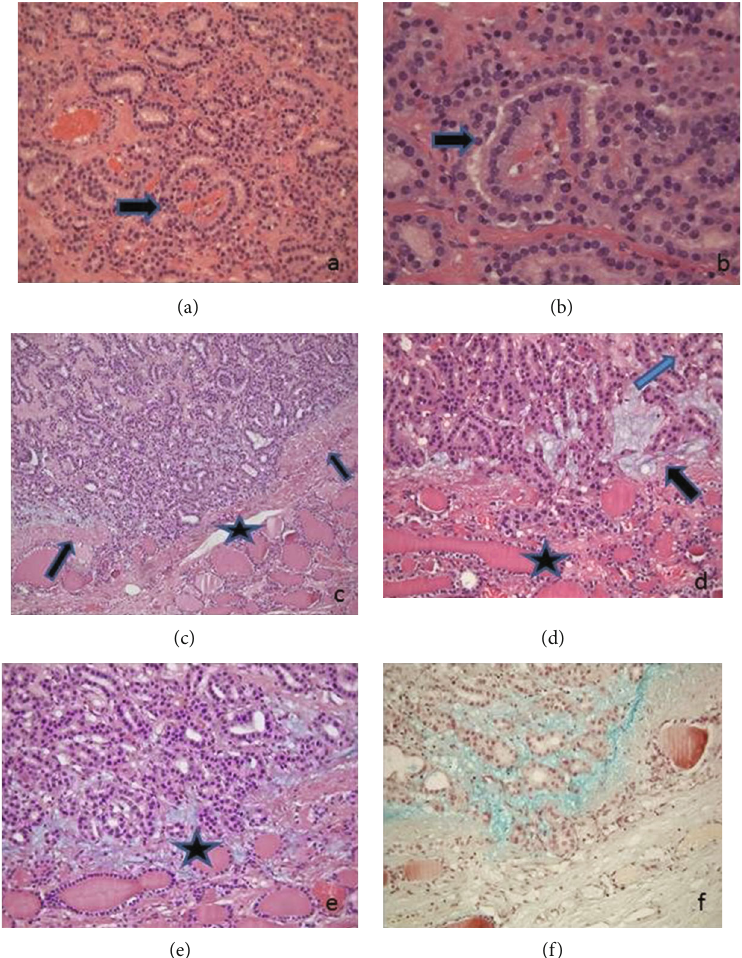
Figure 1: Neoplasia with microfollicular pattern of growth. The follicles are lined by cuboidal cells, lacking nuclear crowding and overlapping. The arrows mark rare epithelial tufts growing within the follicles, with a fi brovascular core, mimicking the appearance of renal glomerulus (a, b) and foci of capsular microinvasion (c, d, e) with stromal mucinous material (arrows) staining positively with Alcian Blue staining (f). H-E staining: (a)=200x, (b)=400x, (c)=100x, (d)=200x, (e)=200x, and (f)=Alcian Blue staining,